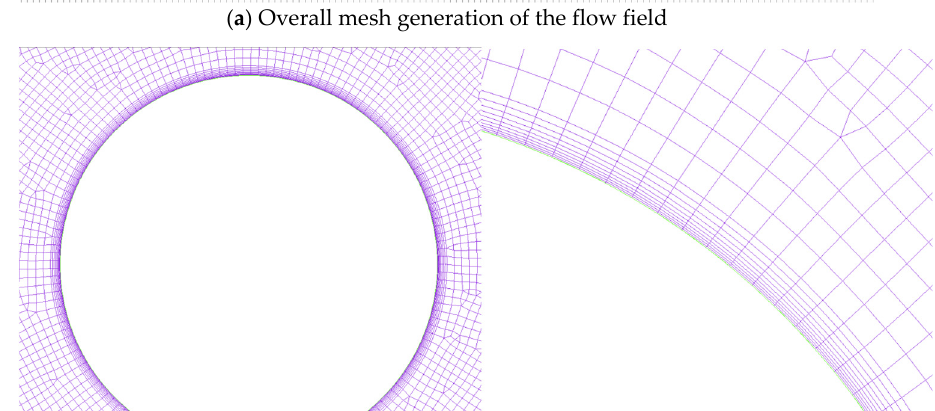
( a ) Overall mesh generation of the flow field